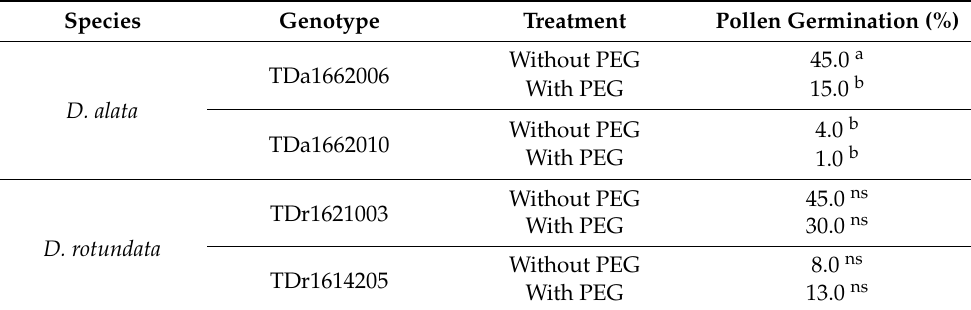
Table 3. Effects of the polyethylene glycol (PEG) on germination percent of yam